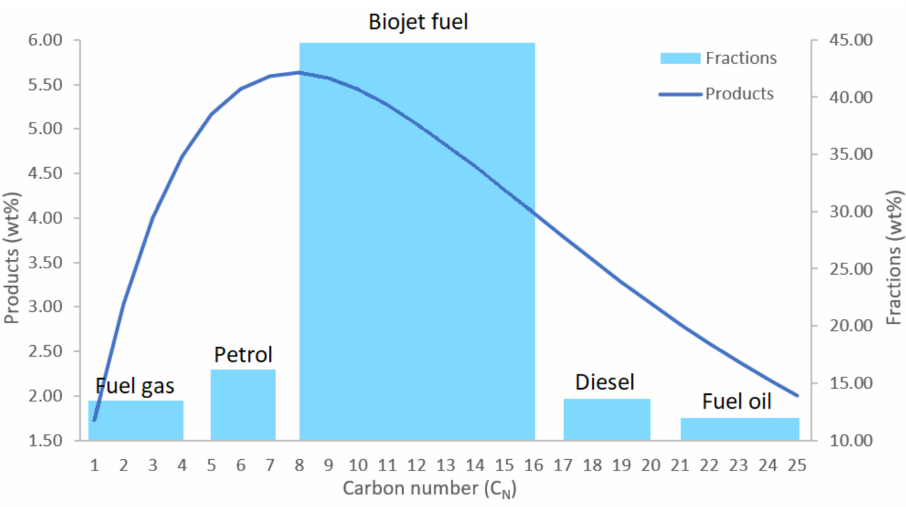
Figure 4. Products and fractions mass